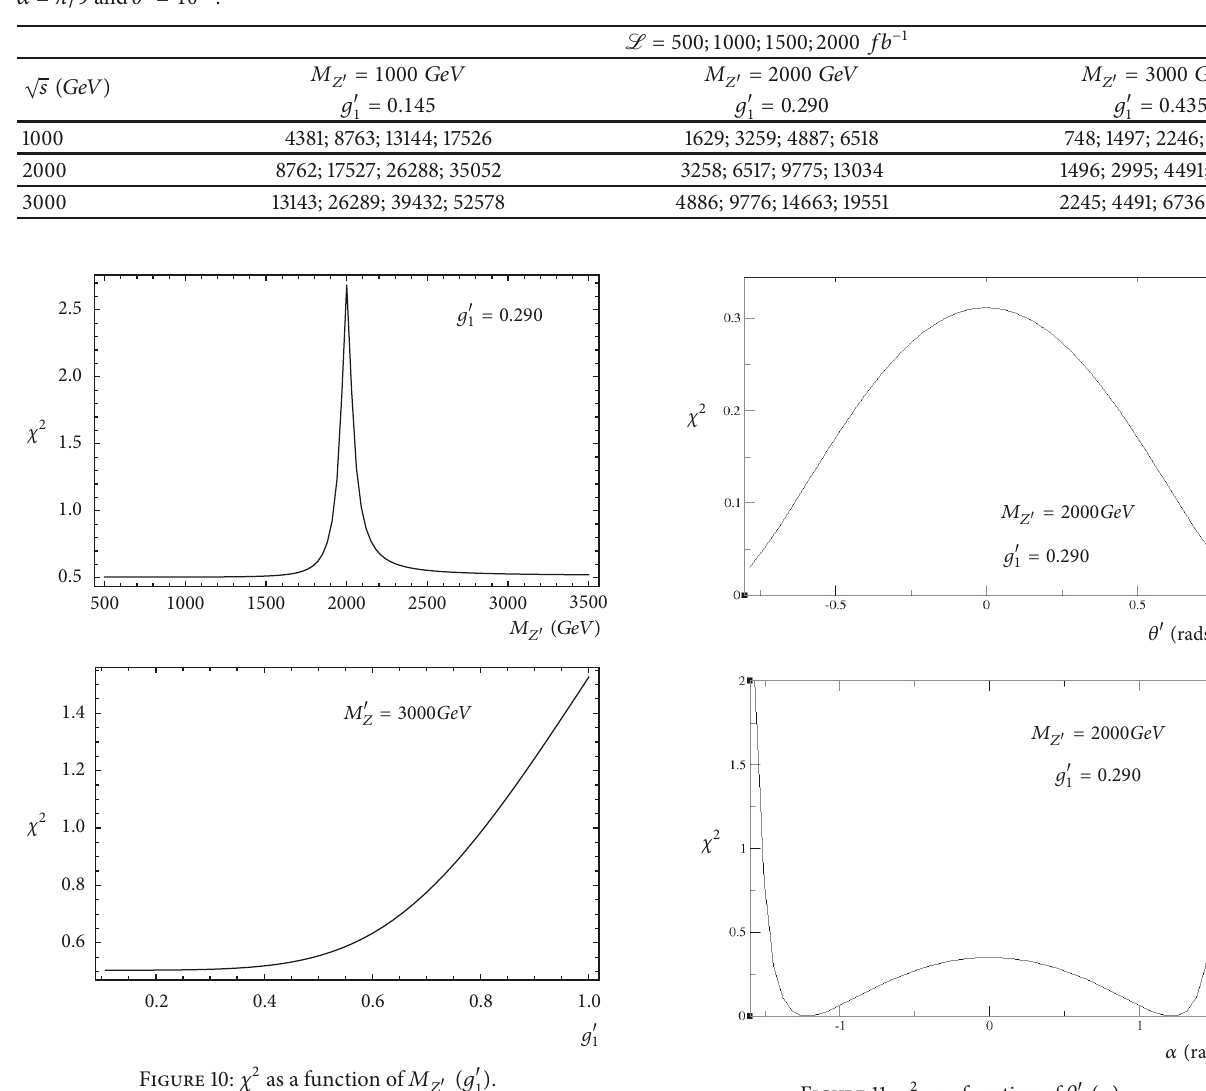
Figure 11: 𝜒 2 as a function of 𝜃 耠 (𝛼)